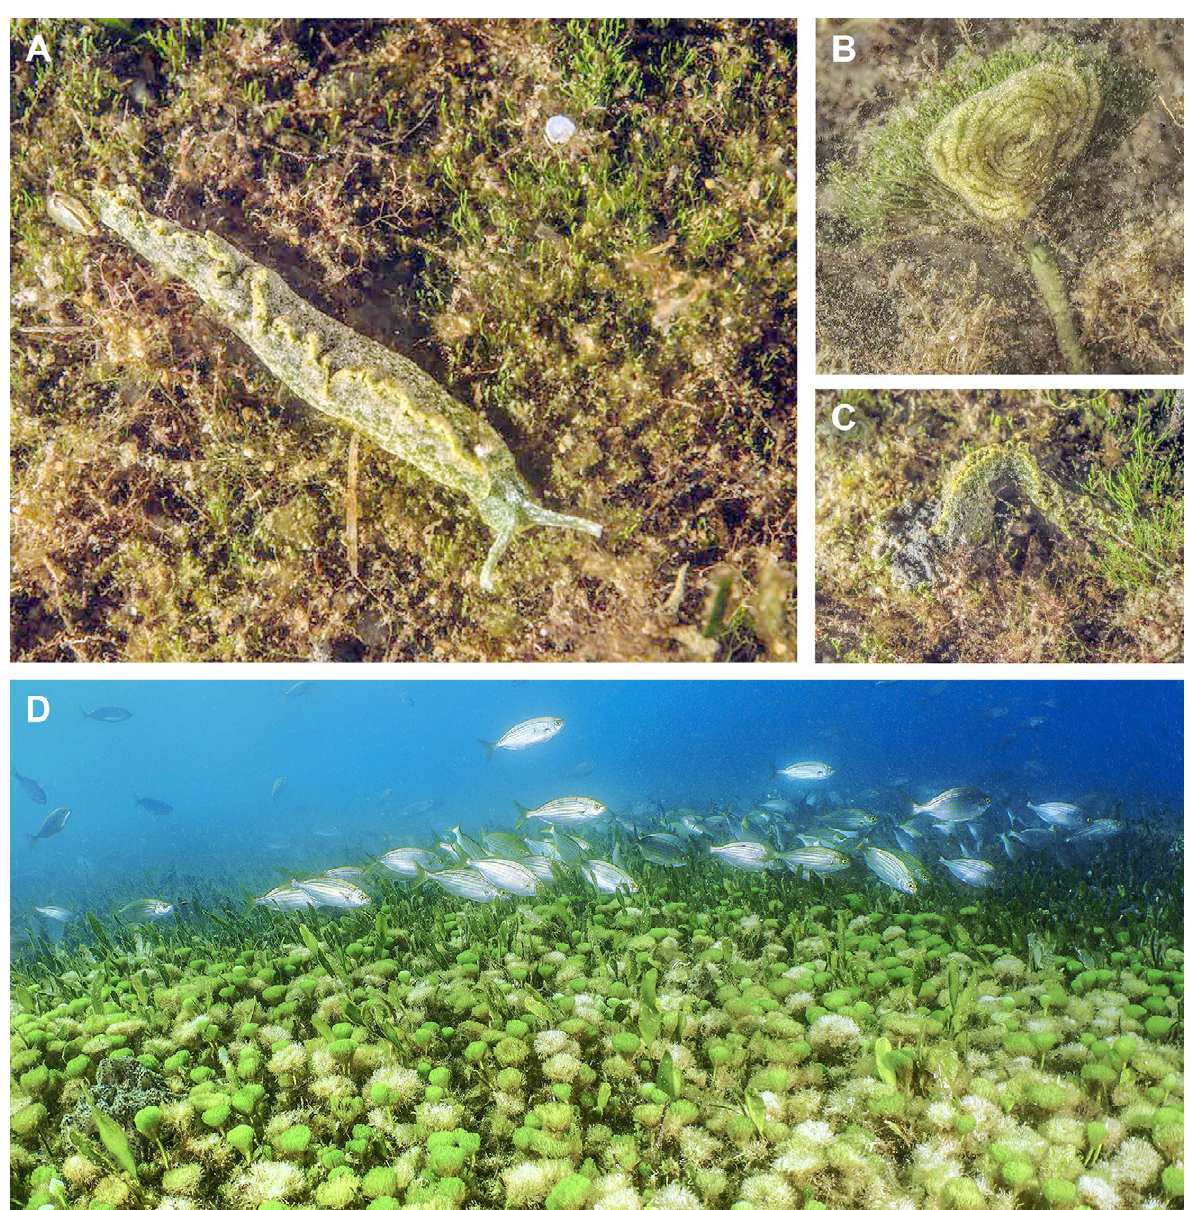
Figure 3. Elysia nealae in the changing seascapes in Lu Carragioni, Olbia, Sardinia (Tyrrhenian Sea) A. Living specimen (voucher specimen RM3_1825) photographed in situ . B. Coiled egg mass on the erect form of Penicillus capitatus . C. Animals burrowing in the sediment in response to light (voucher specimens RM3_1825 and RM3_1827). D. Wide view of one of the patches of Penicillus capitatus where E. nealae was